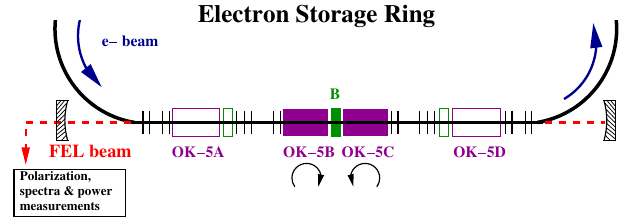
FIG. 1. Undulator configuration for the polarization control of FEL beams. The two helical undulators in the middle of the FEL straight section (OK-5B and OK-5C) are turned on and operated in opposite helicities. Buncher B is used as a phase shifter.